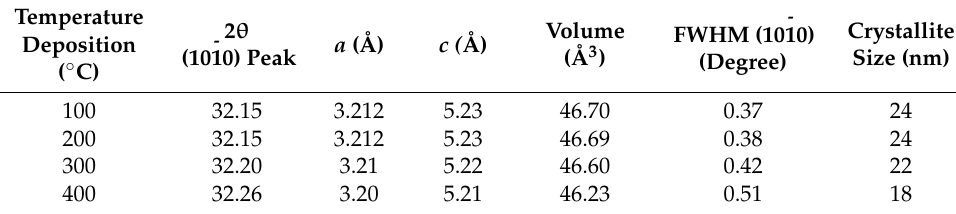
Table 3. Structural Properties of Sb 0.14 GaN Thin Films Deposited at Temperatures Ranging from 100 to 400 ◦ C from the X-ray Diffraction Analyses.